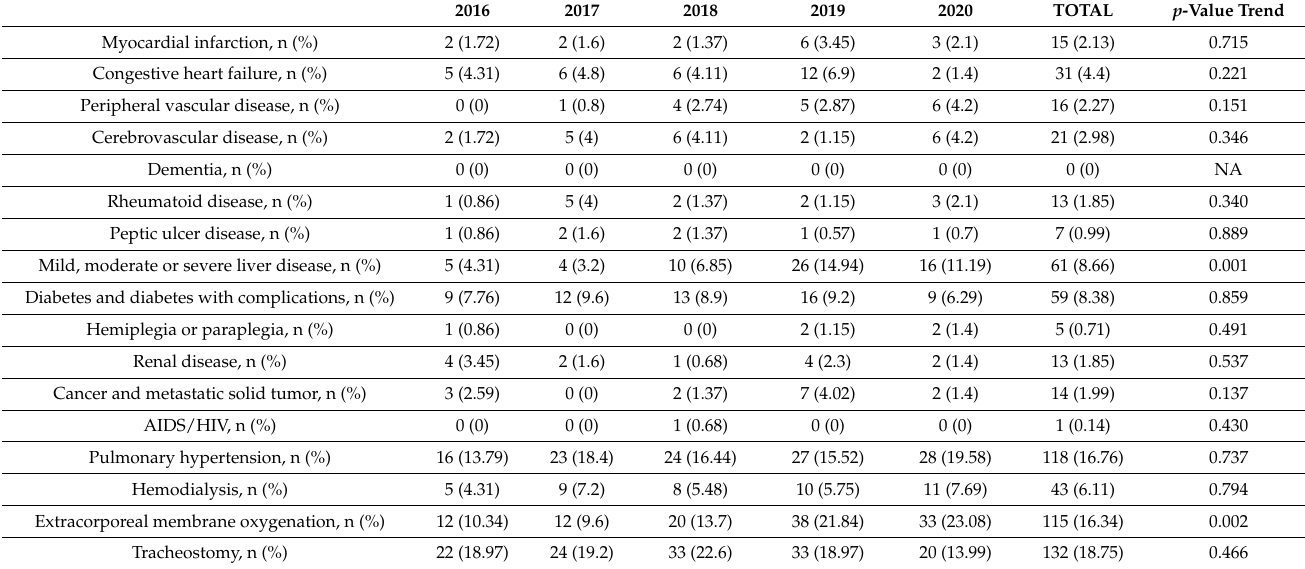
Table 2. Comorbidities included in the Charlson Comorbidity index, pulmonary hypertension and procedures on hospitalized patients with COPD who underwent lung transplantation in Spain